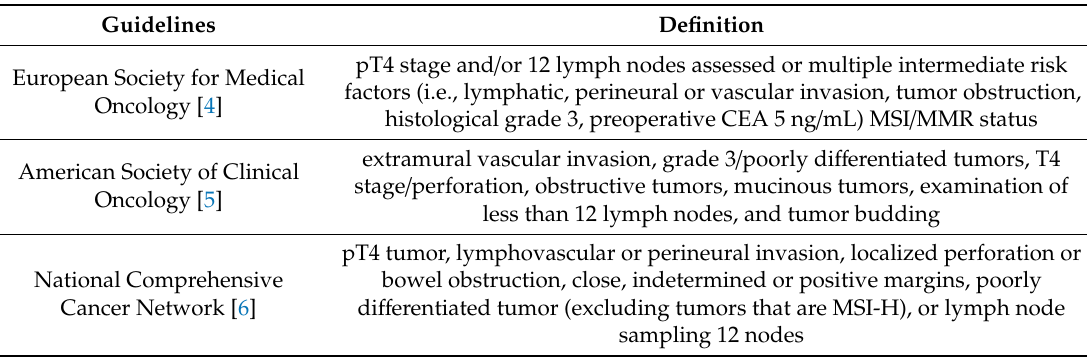
Table 1. Definitions of high-risk stage II colon cancer according to international